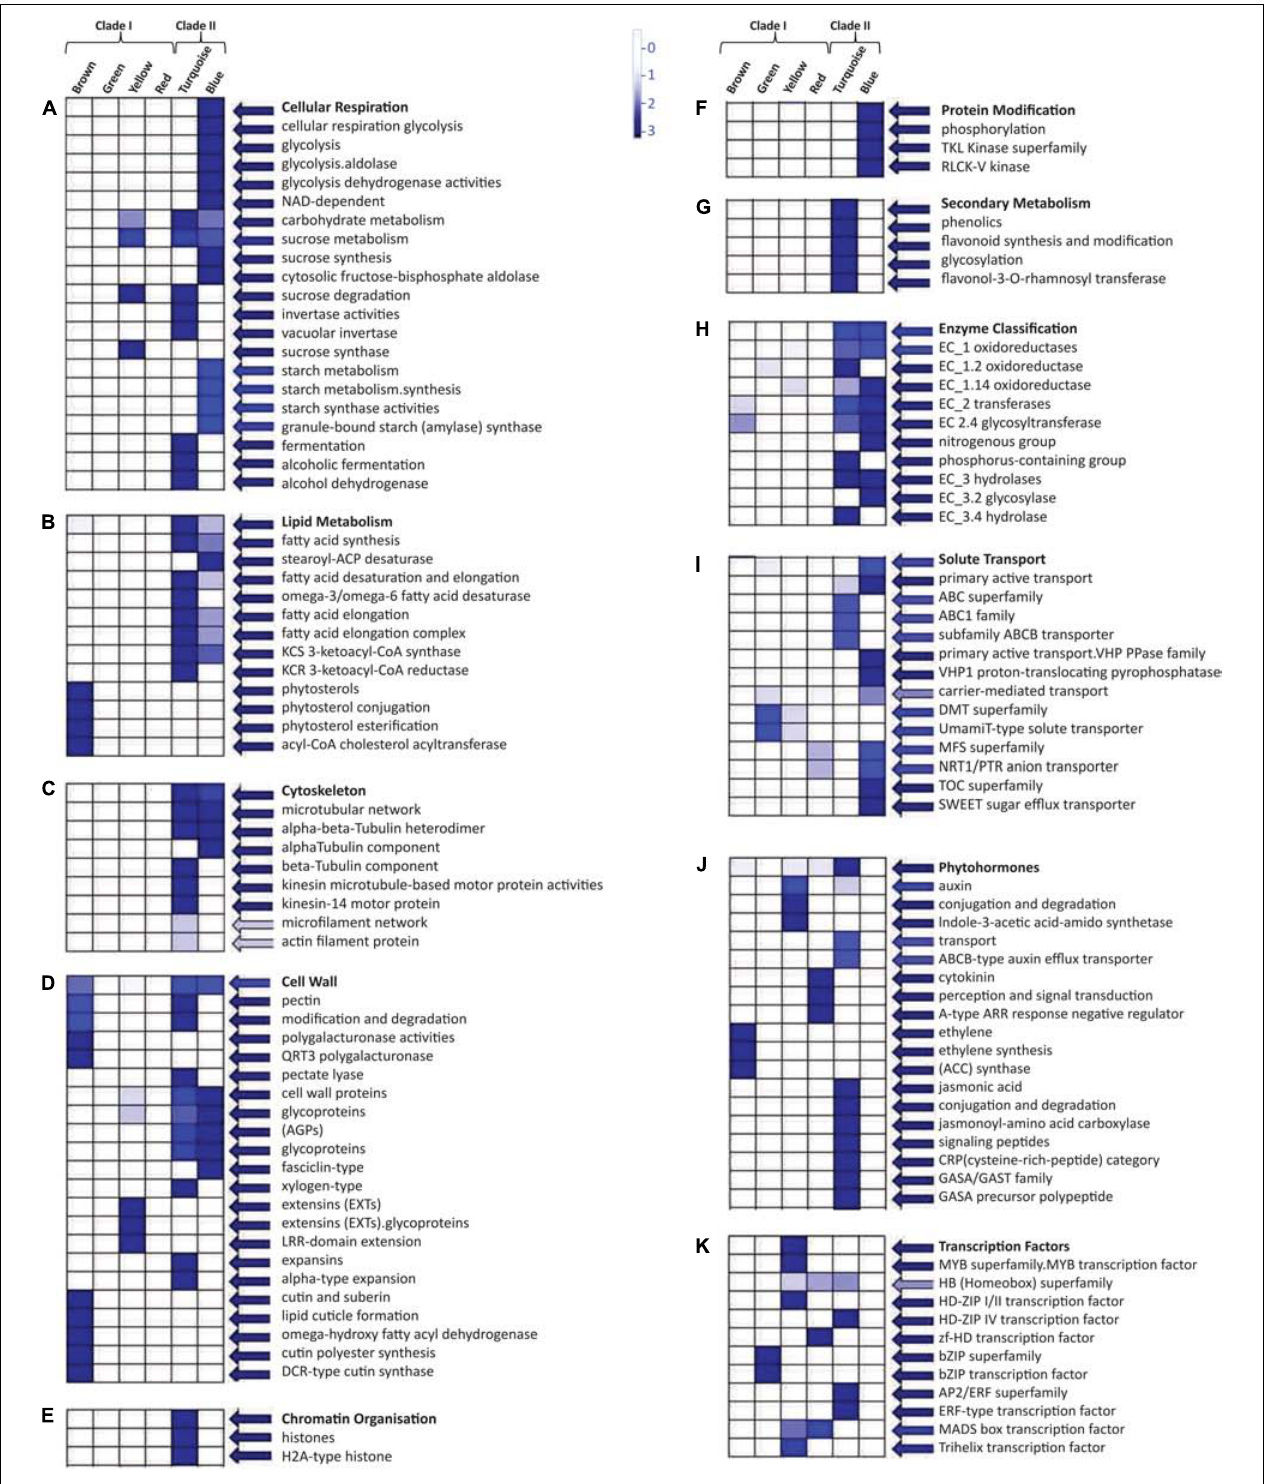
FIGURE 5 | Mapman based significant functional classification of two different clades. These two clades consist of six modules that were involved in different pathways: (A) cellular respiration and carbohydrate metabolism, (B) lipid metabolism, (C) cytoskeleton molecules, (D) cell wall-related functioning, (E) chromatin organization, (F) protein modification, (G) secondary metabolism pathway, (H) enzymatic action, (I) solute transportation, (J) phytohormone, and (K) transcription factors. BINs color code ranging from 0 to 3 with the vertical bar that represents the log2 expression value of each module.